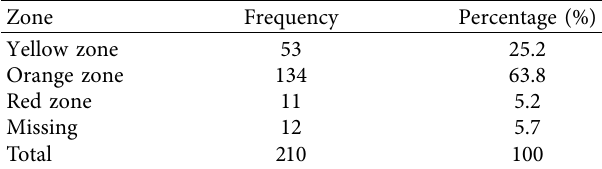
Table 2: Various zones at the emergency and their rates of DAMA.